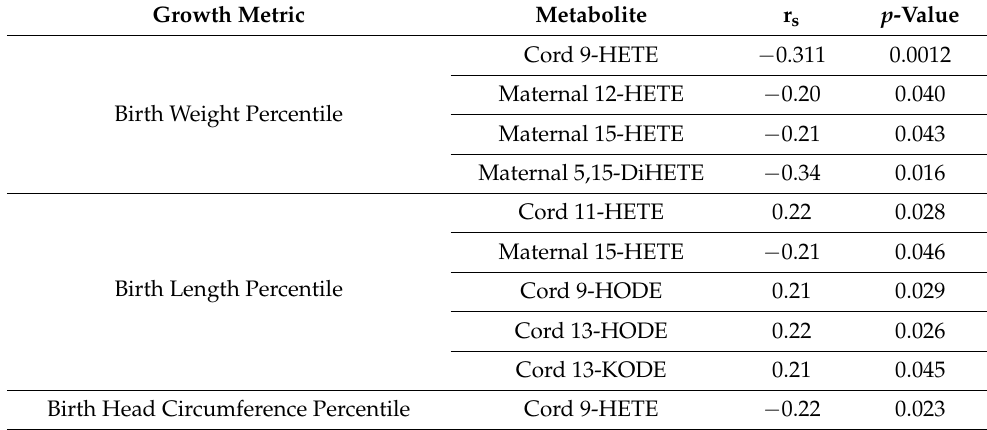
Table 9. Significant correlations between n-6 plasma metabolite levels and infant growth